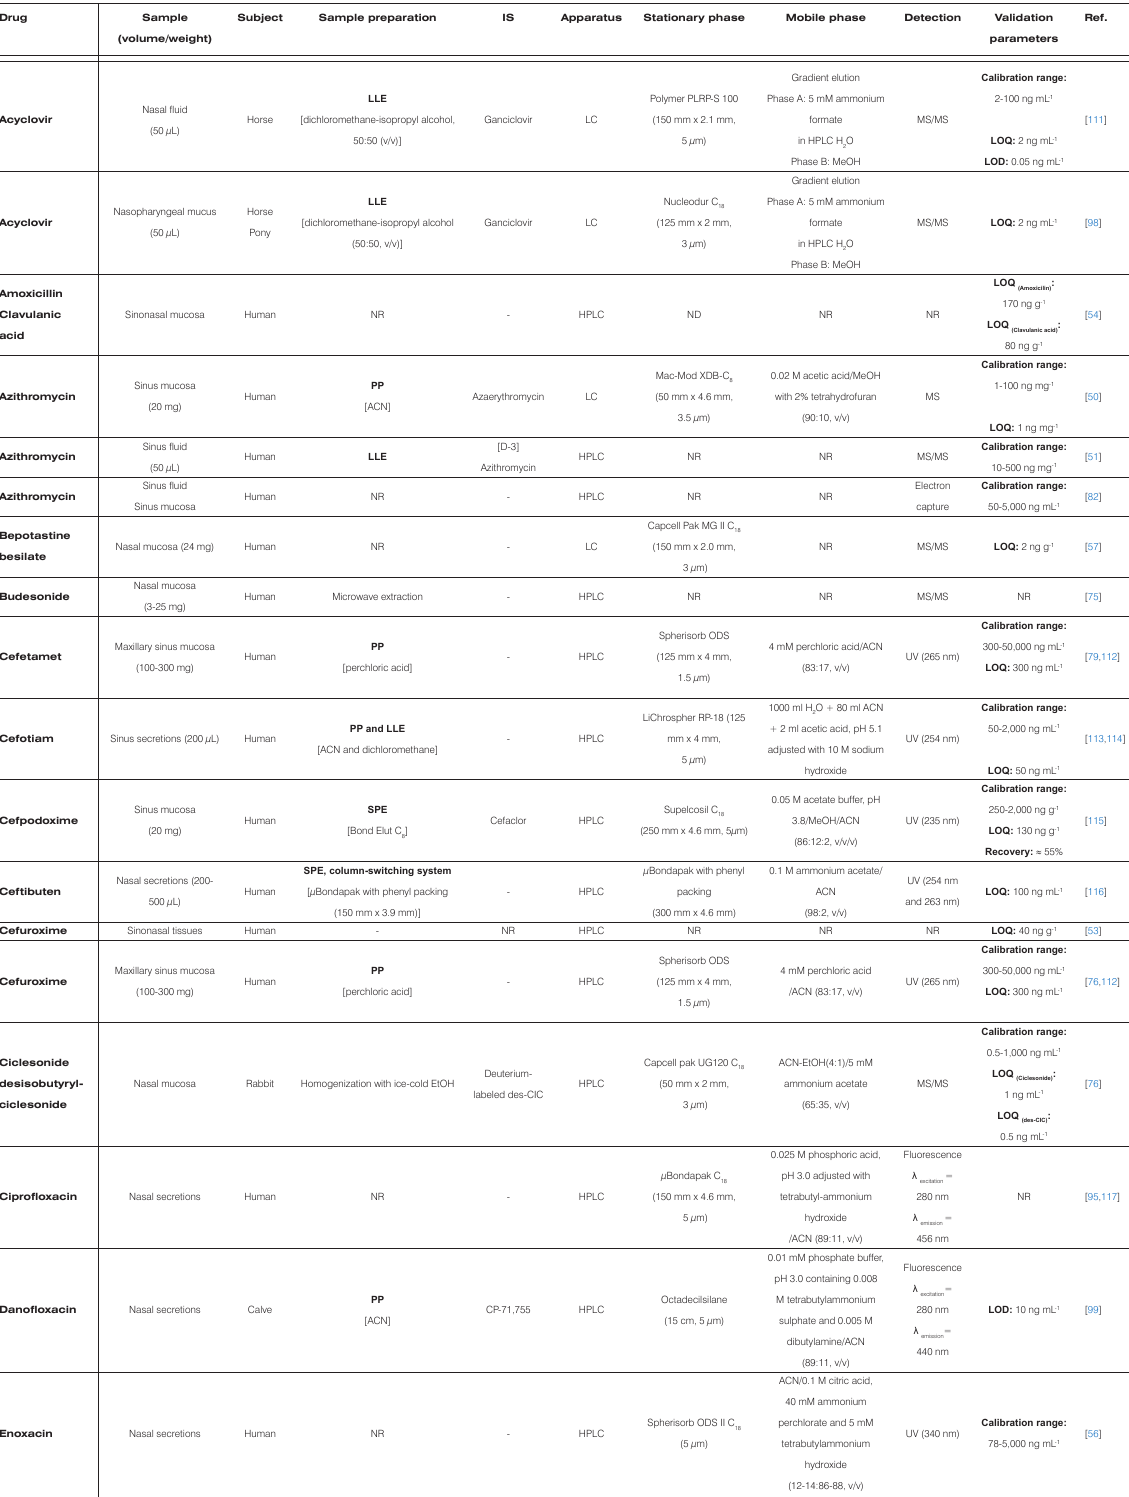
Table 2. Liquid chromatographic methods for quantitative determination of drugs in nasal and paranasal